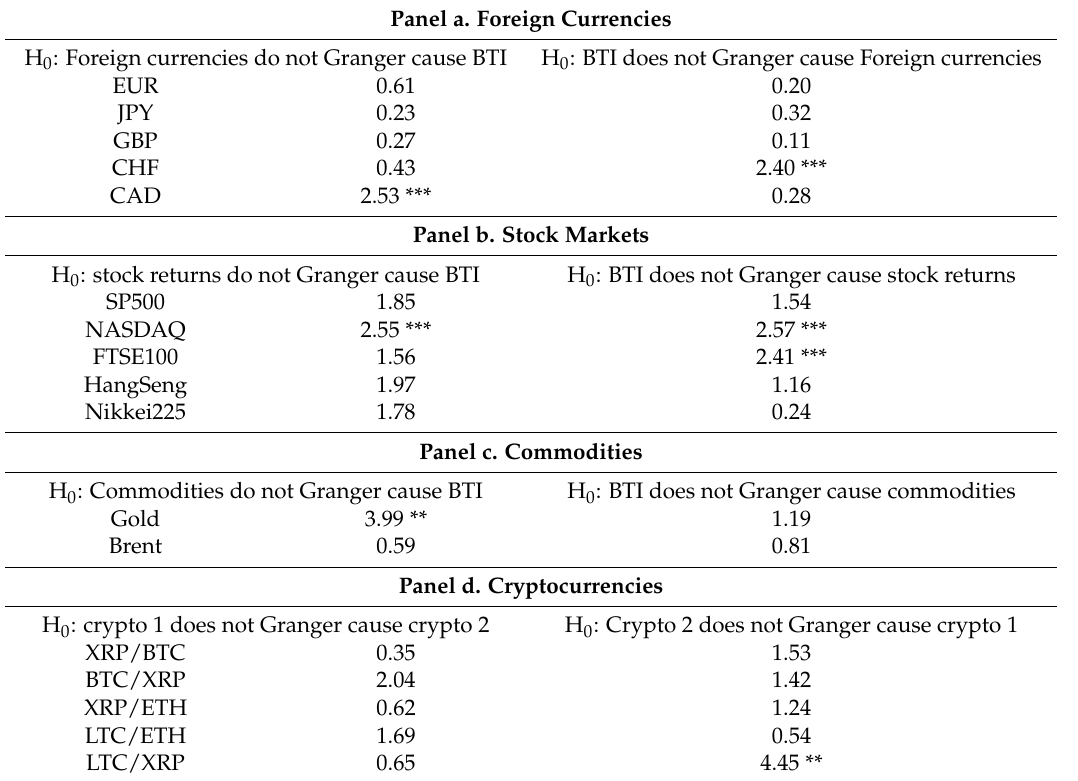
Table 6. Pairwise Granger